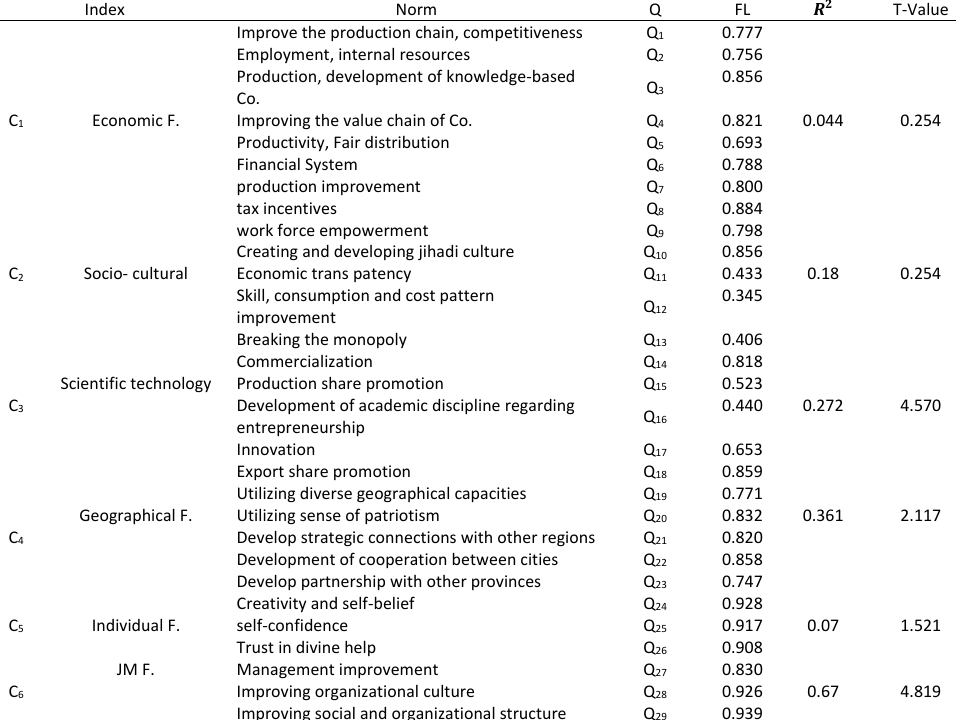
Table6: summary confirmatory factor analysis results of research scale